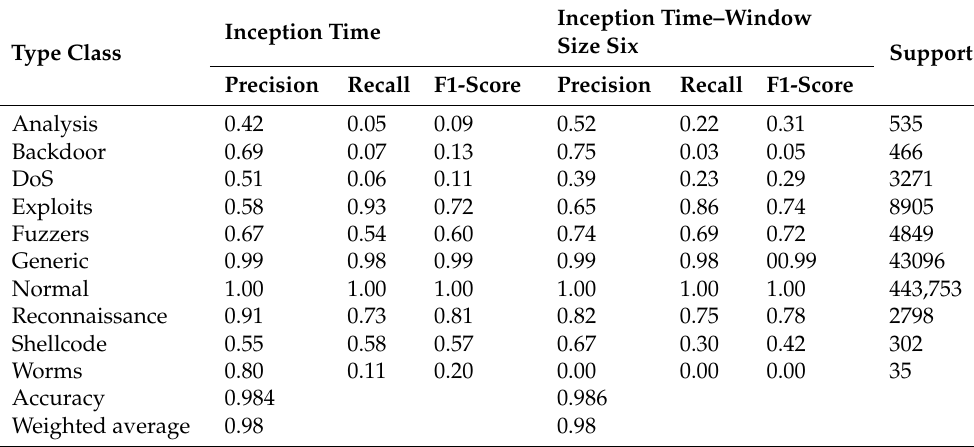
Table 10. Classification report comparison between Inception Time and inception time with six windows using the UNSW-NB15 dataset.